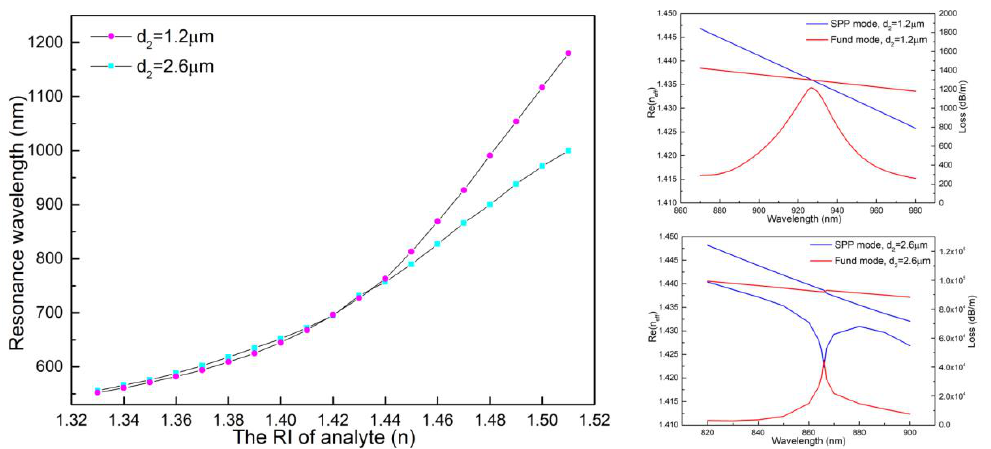
Table 1. Comparison of the proposed sensor with existing sensors.